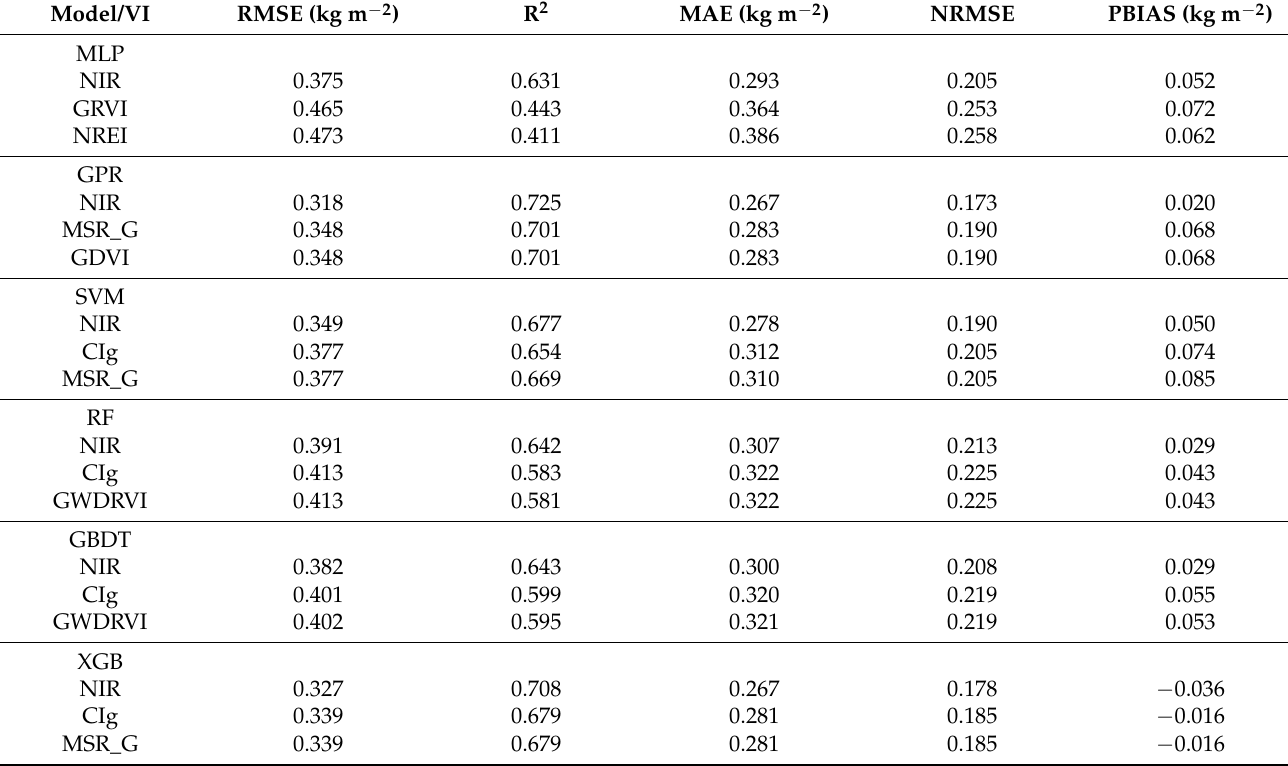
Table 5. Top three VIs for estimating AGB based on six different ML models.